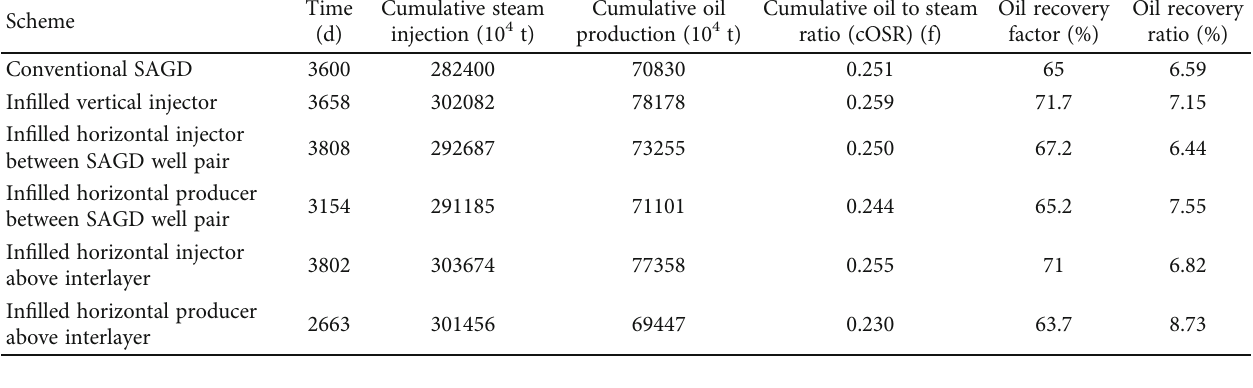
Table 4: Comparison of production characteristics for model